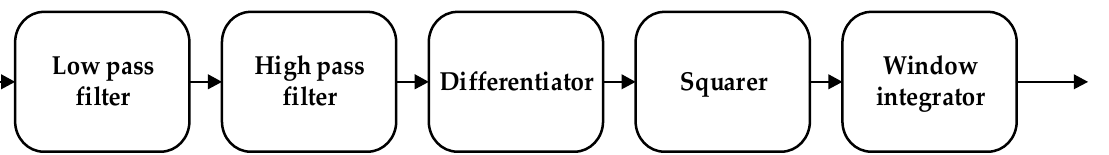
Figure 3. Data pre-processing process.